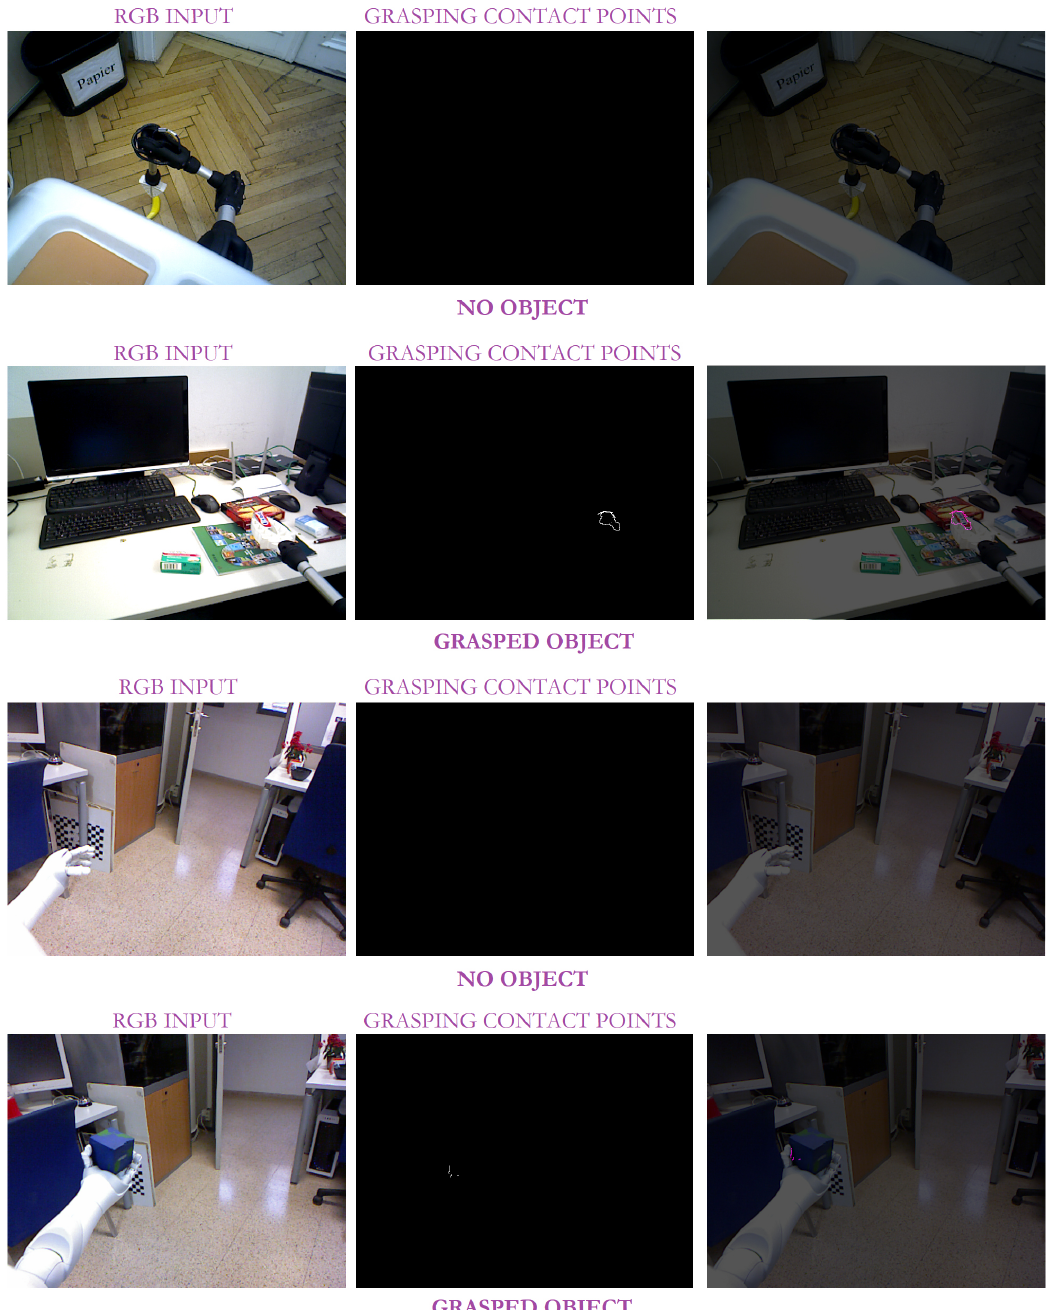
Figure 13. Some experimental results of our approach with the Hobbit and Pepper robots in assistive tasks: the left column corresponds to the input RGB image; the middle column illustrates the detected contact points; and the last column shows the overlapping between the original image and the detected contact points (in